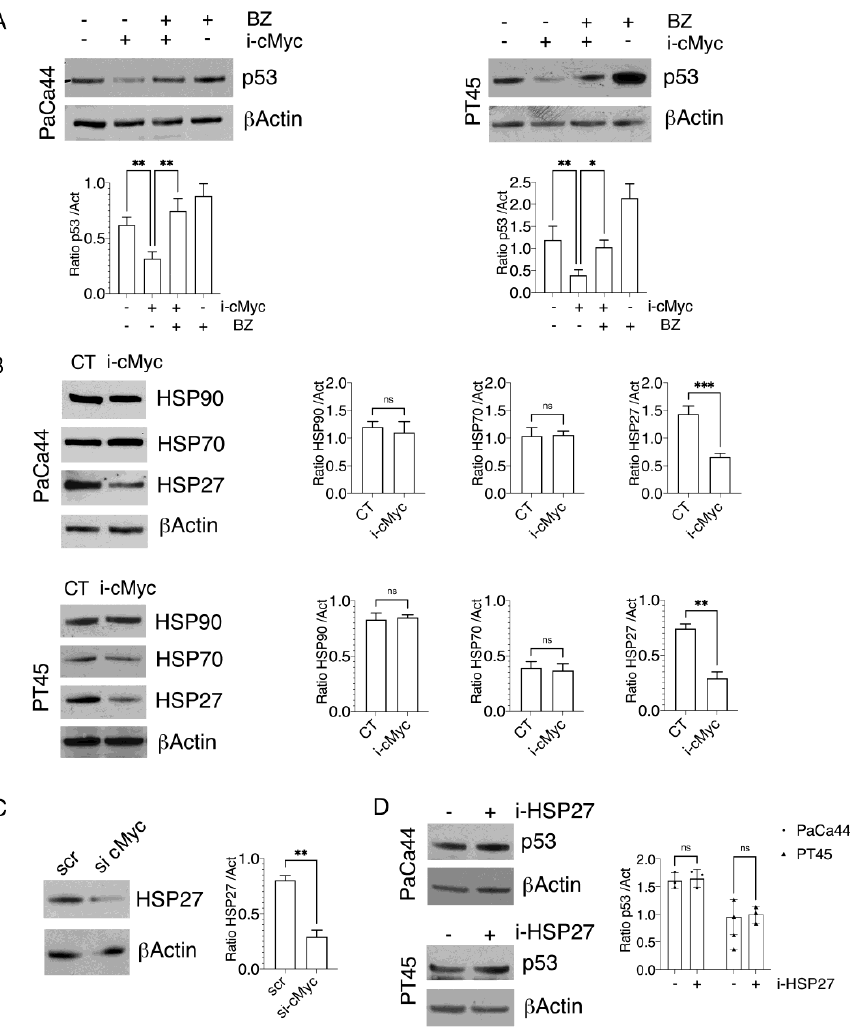
Figure 2. c-Myc inhibition promotes the proteasomal degradation of mutp53 independently of HSP modulation. ( A ) PaCa44 and PT45 cells were treated with cMyc inhibitor (i-cMyc) (50 Μm ) for 48 h,